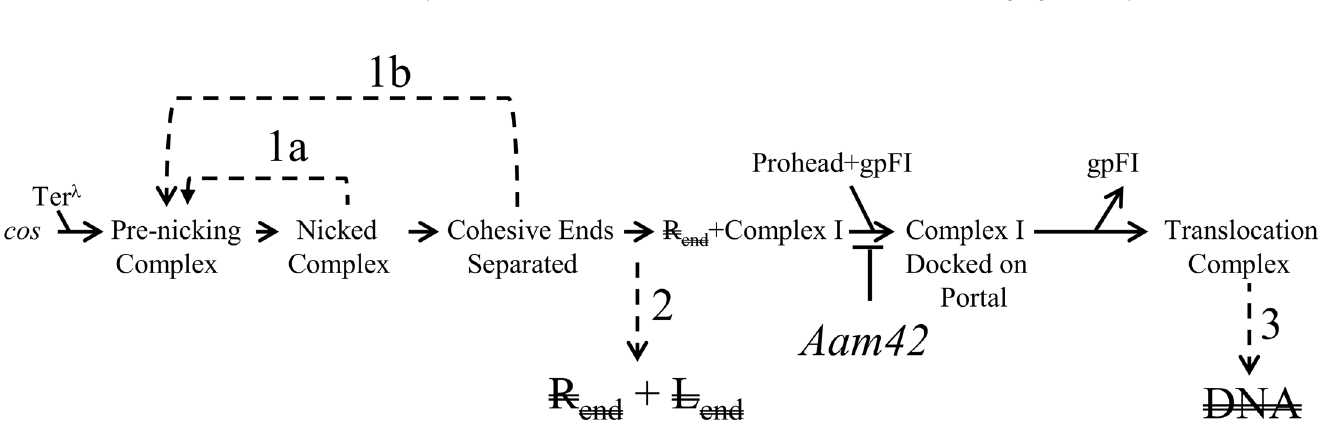
PLOS ONE | DOI:10.1371/journal.pone.0154785 May 4,